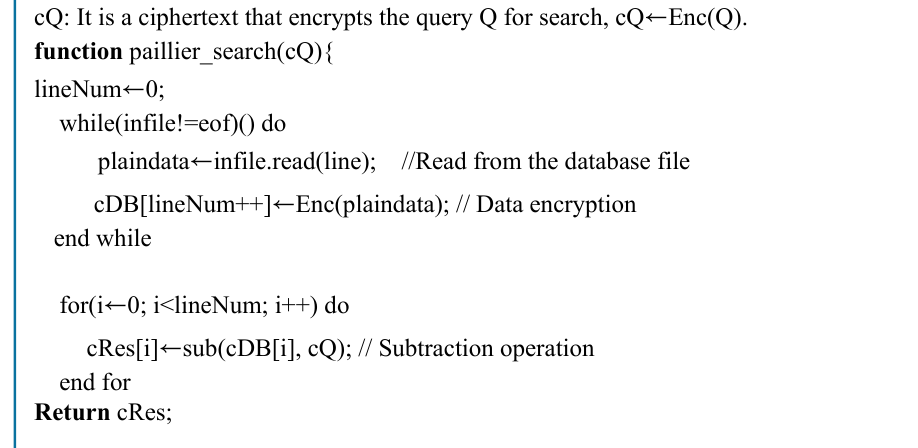
Table 2. Performance Evaluation Environment.